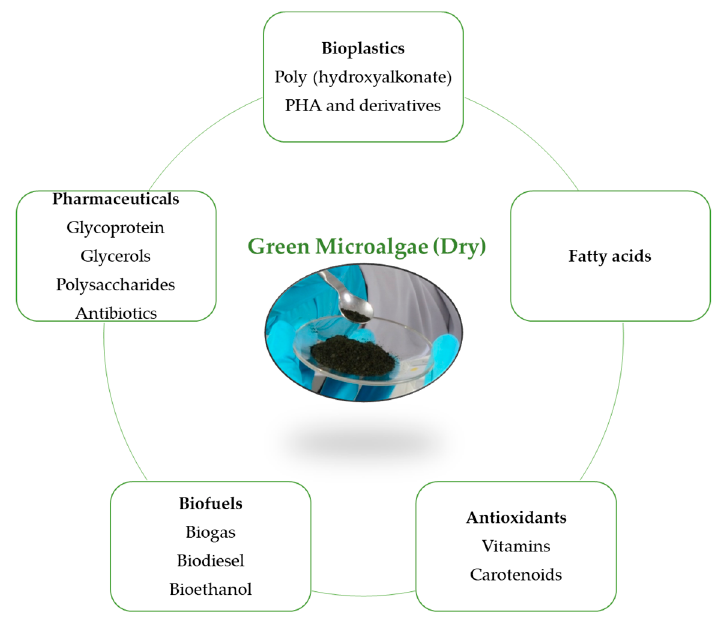
Figure 4. Common products of microalgae [18,19].